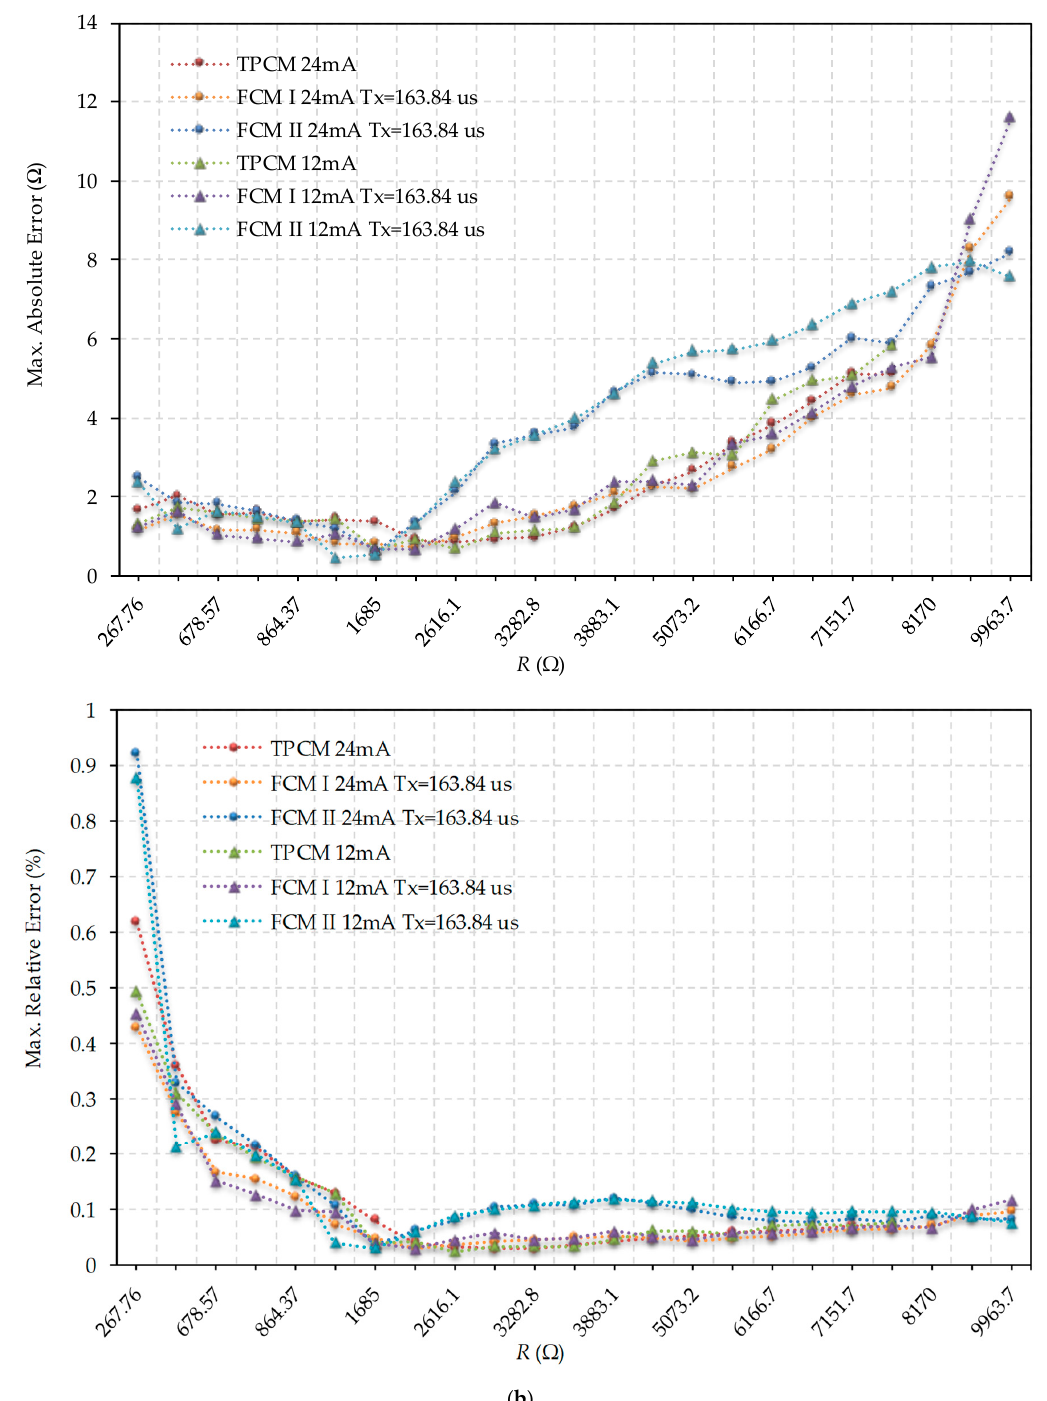
Figure 8. Comparison between errors evaluating R using the TPCM and the two FCMs for T x = 163.84 µs and for maximum output current configurations of 12 mA and 24 mA. ( a ) Comparison between the maximum absolute errors, ( b ) Comparison between the maximum relative errors.